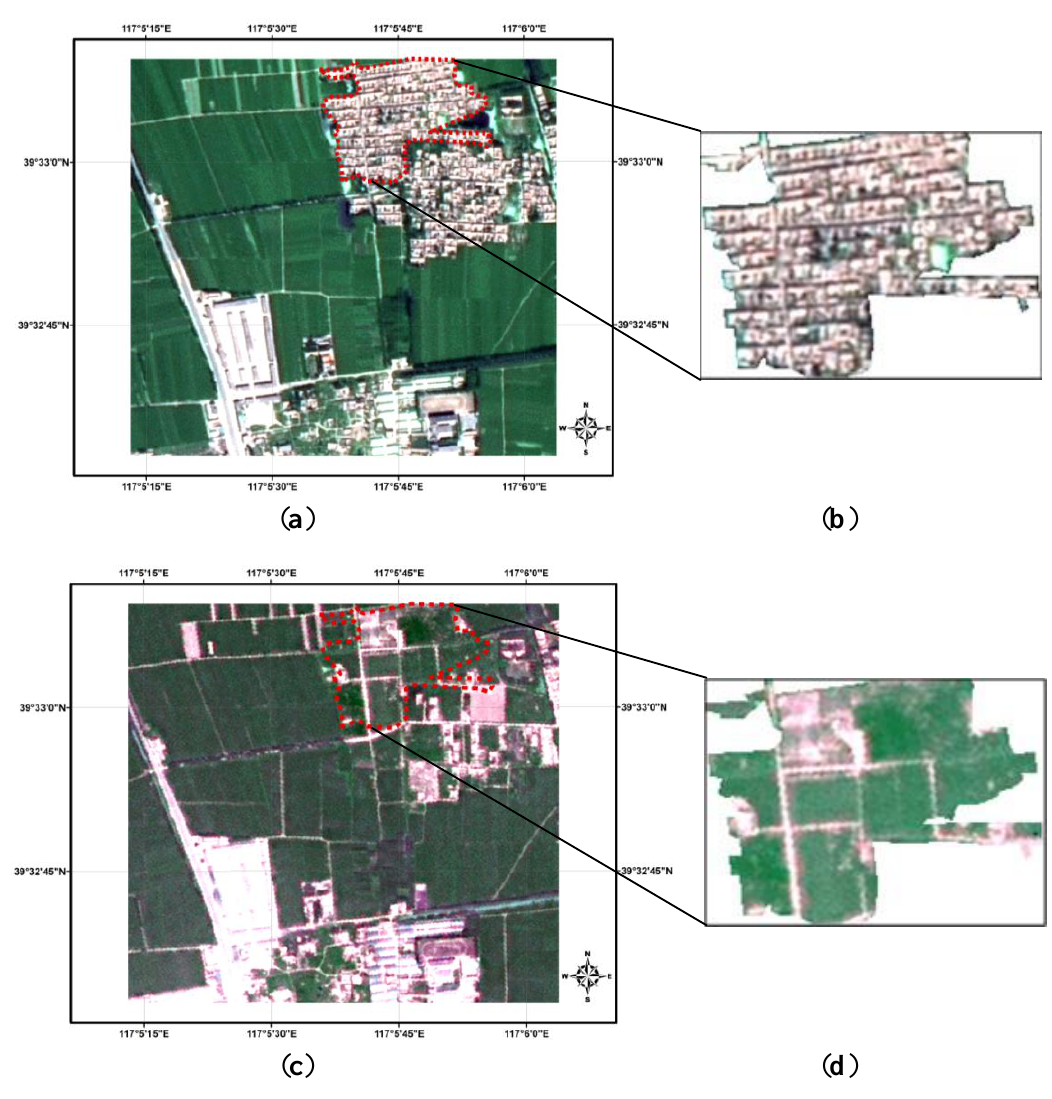
image. ( b ) Before change (residential 1 image. ( d ) After the change (non residential 2